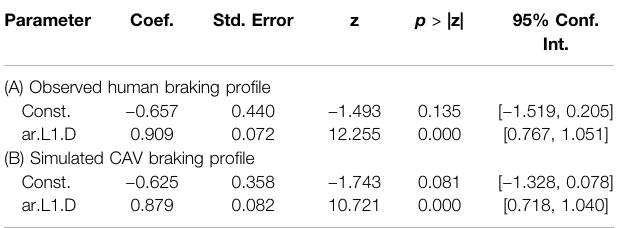
TABLE 7 | ARIMA model results for (A) Human, and (B) Simulated CAV braking pro fi les under car-following driving condition. Parameter Coef. Std. Error z p > |z| 95% Conf.